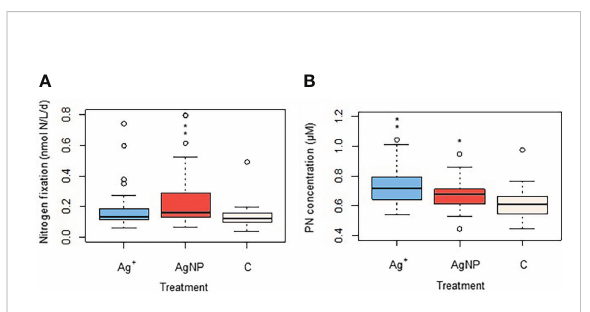
(Kruskal-Wallis test: x 2 (2)=0.415, n =108, p =0.812. Phosphate and silicate concentrations decreased in time between Day 0 and Day 11 in all treatments, though with obvious differences between treatments (Figures 4B, C). Phosphate concentrations on Day 0 were 3.3 ± 0.3 nM, 3.8 ± 0.7 nM and 3.8 ± 0.2 nM